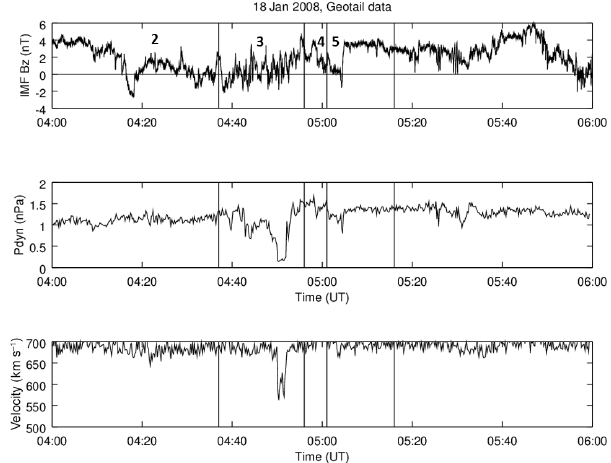
Figure 9. Geotail measurements of IMF Bz (top, GSM coordi- nates), dynamic pressure (middle), and velocity (bottom). The pe- riods 2–5 from Fig. 4 are marked here with the black vertical lines and numbers with the assumption that the propagation time from the magnetopause to ionosphere is